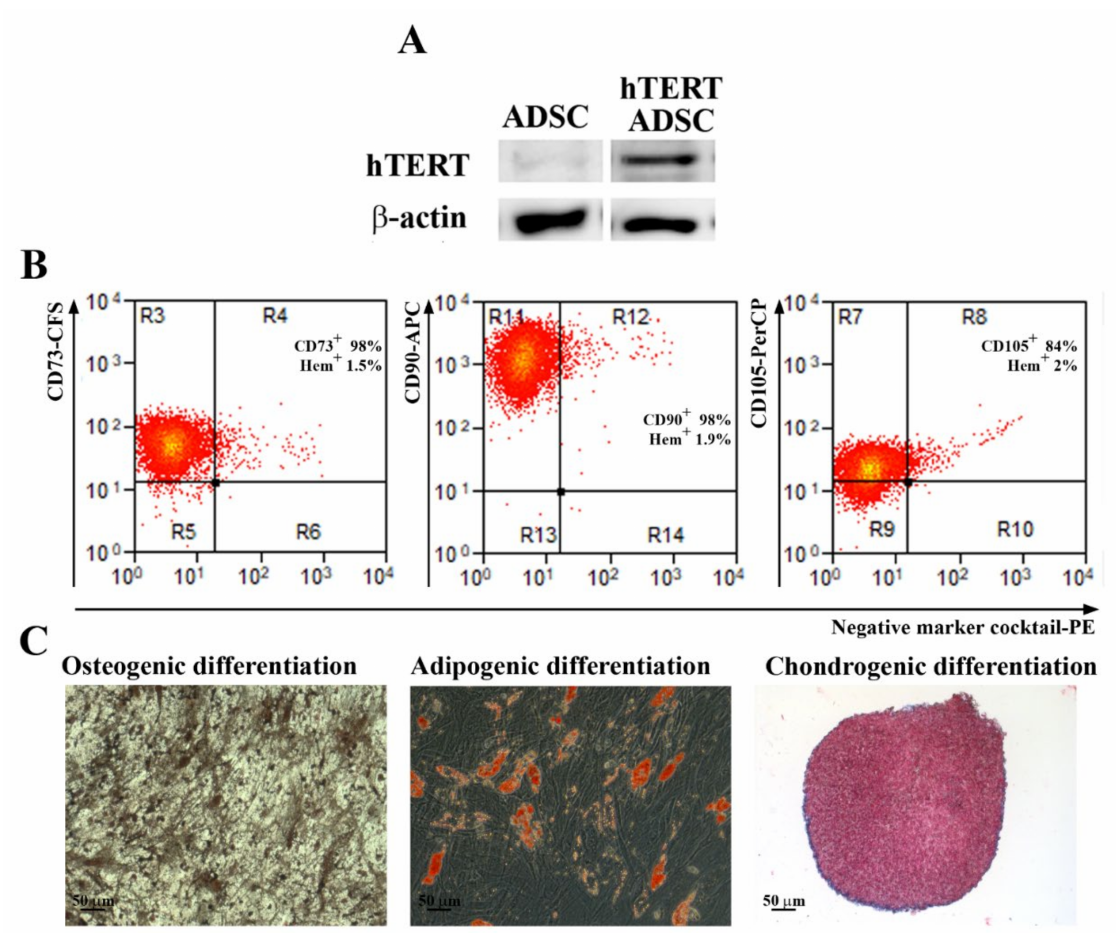
Figure 2. Analysis of hTERT expression, stem cell markers and differentiation potential of hTERT transduced ADSC. ( A ) Expression of hTERT before and after hTERT transduction as revealed by Western Blot technique. ( B ) Flow cytometry analysis showing that the expression of surface markers CD73, CD90 and CD105, required for mesenchymal stromal/stem cells definition, was not lost after lentiviral transduction up to the 31st passage ( n = 3). ( C ) Evaluation of multilineage differentiation capacity of hTERT transduced ADSC. Note that, a short time after transduction (5th passage), the cells were able to properly differentiate into osteogenic and adipogenic lineages, and less into chondrocytes, since the Alcian Blue staining was hardly